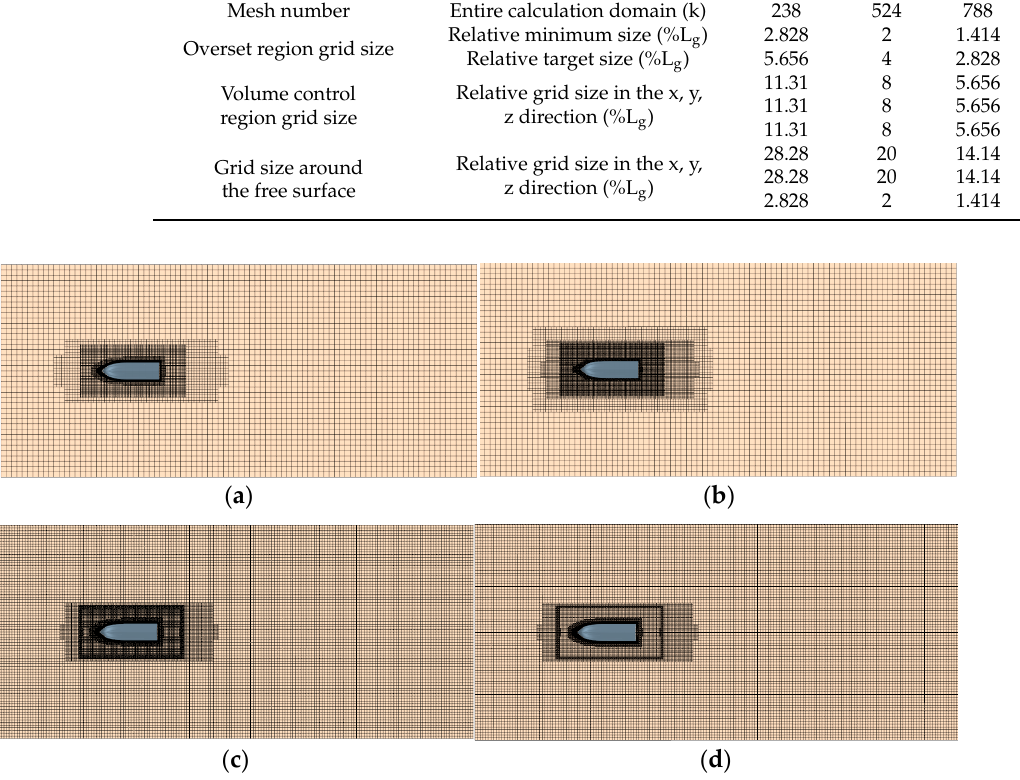
Figure 10. The four designed grids: ( a ) grid 4, ( b ) grid 3, ( c ) grid 2, ( d ) grid 1.